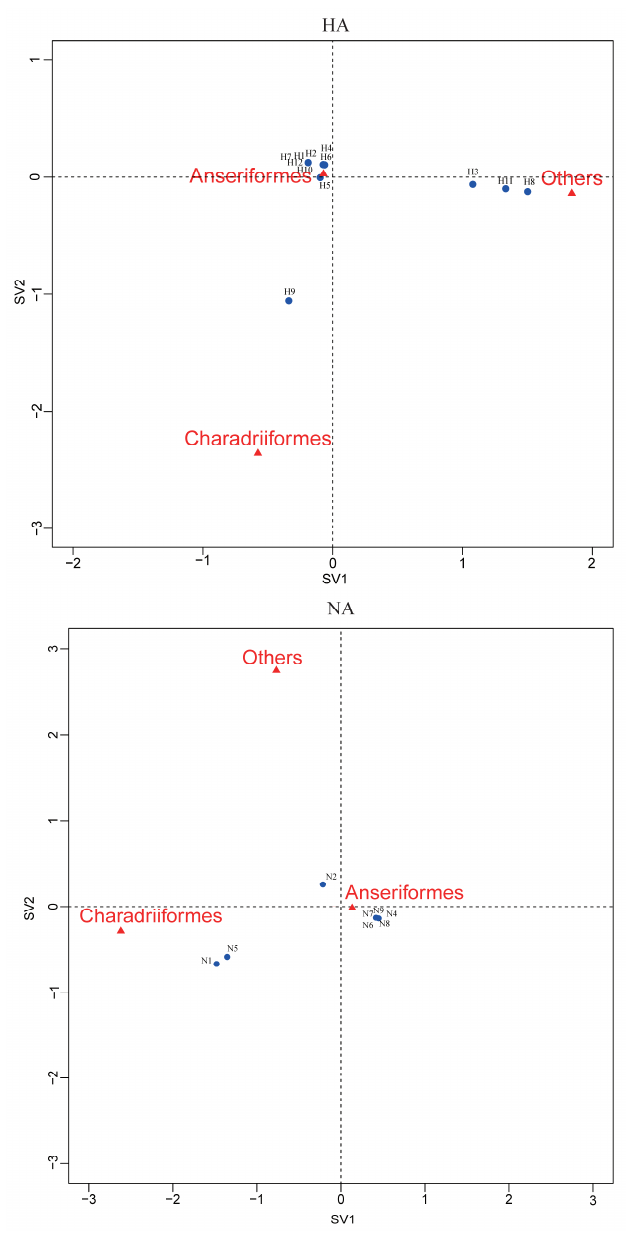
Figure 4. Correspondence plot showing the association between bird orders and HA, NA subtypes in two dimensions (singular value (SV)1 and SV2). All subtypes were detected during influenza A virus surveillance in wild birds in Shanghai, 2016-2018.